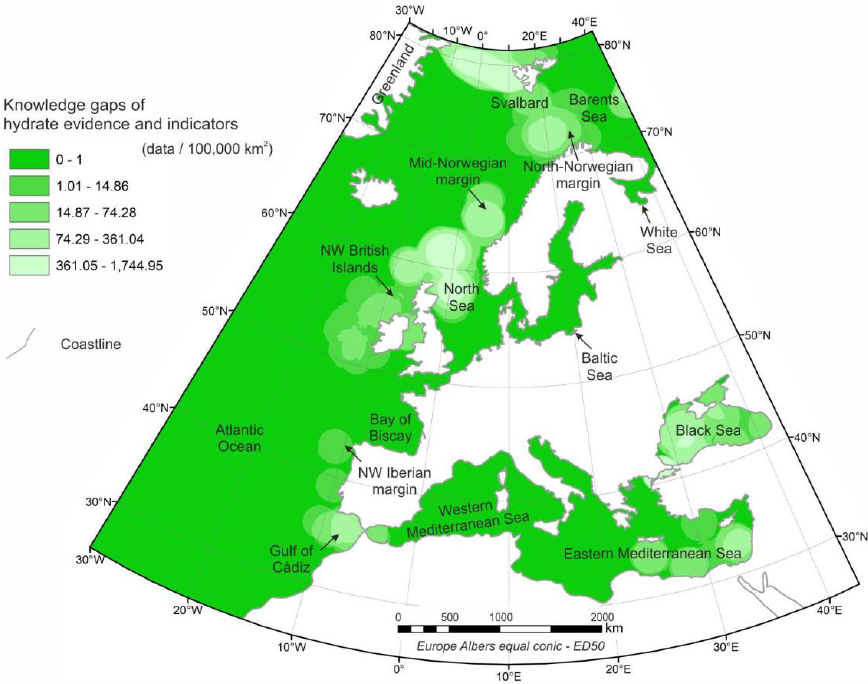
Figure 6. Knowledge gap assessment of hydrate evidence and indicators. Density map developed with the “point density” algorithm of ArcGIS ® . Pixel value, number of items of evidence and indicators of hydrates per 100,000 km 2 . Parameters: population field, none; cell size, 5000; radius, 178,415 metres; areal units, square kilometres; method, geodesic.